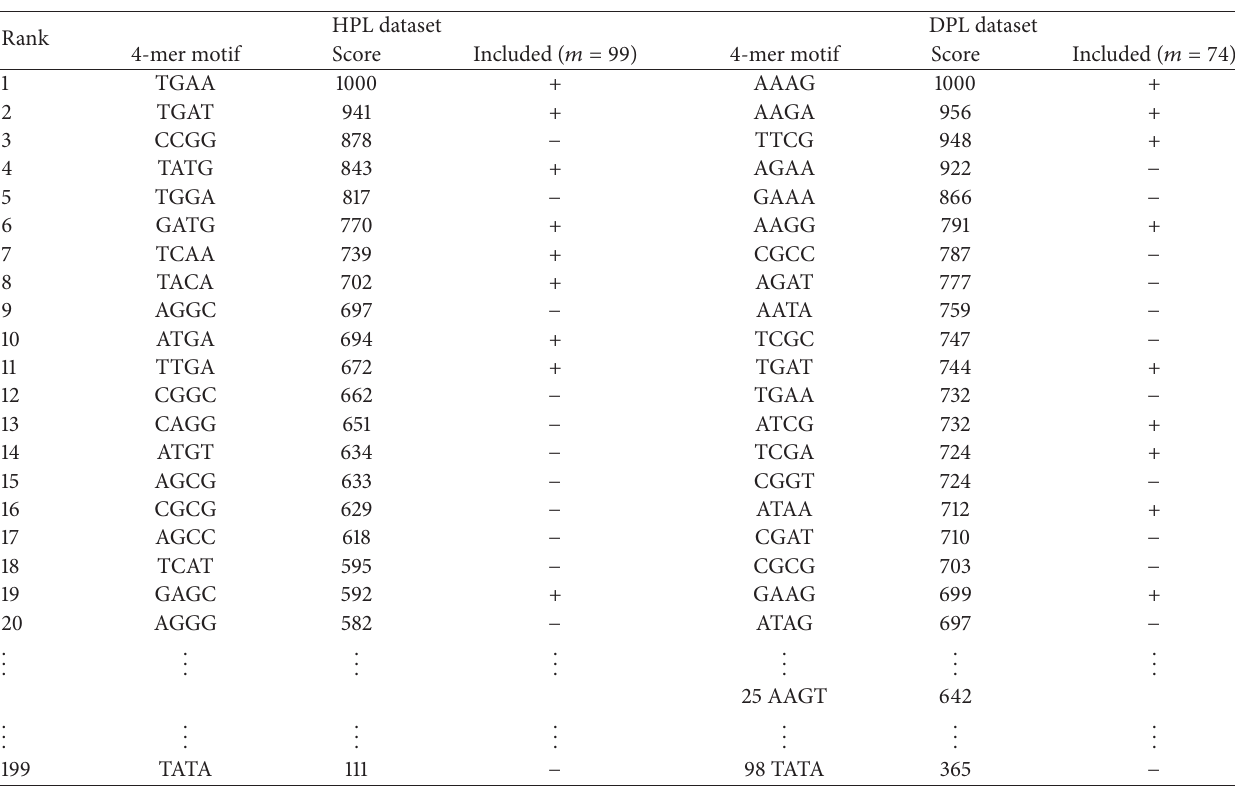
Table 4: Top 20 descriptors of 4-mer motifs. Top 20 descriptors of the 4-mer motifs are contained in the reference set of 167 DNASDs. The descriptors of the TATA motif are ranked at the 199th and 98th when applied for the HPL and DPL datasets,